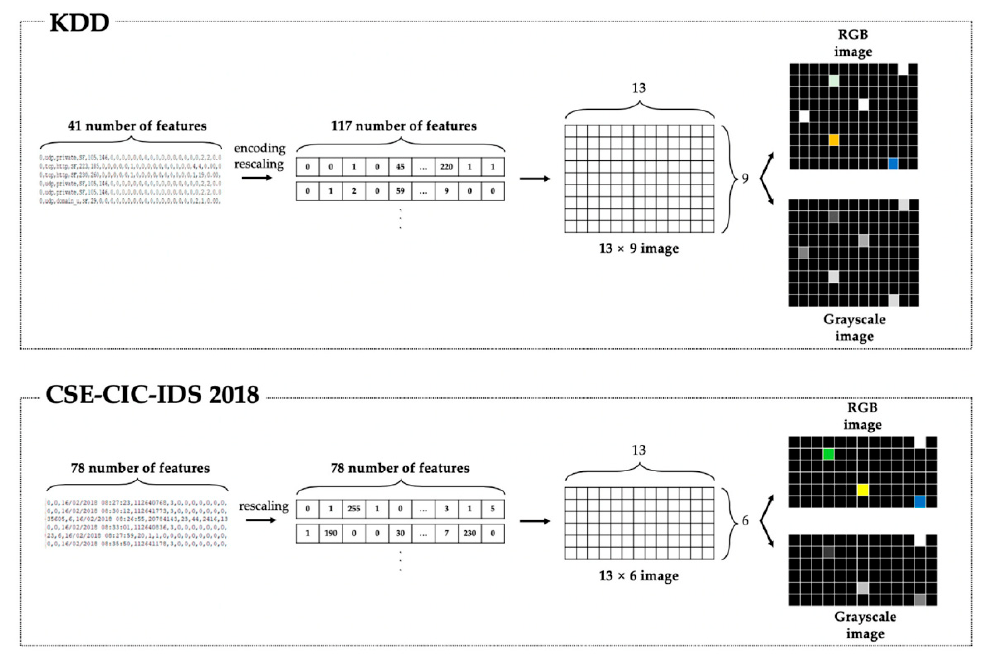
Figure 1. Kim et al.’s [24] approach for NTF transformation into two kinds of picture datasets. The experimental results on the KDD dataset show that the RNN model has 99% accuracy in binary classi fi cation, almost the same as that of the CNN model. In multiclass classi fi cation, the RNN model has accuracy of 100% in smurf detection while the accuracies of the neptune and benign are 80% and 85%, respectively.